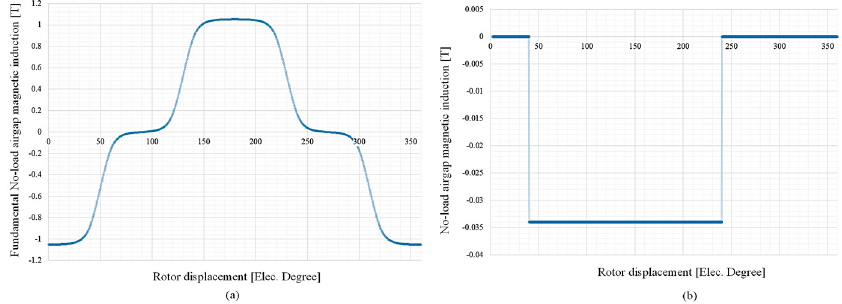
Figure 4. Comparison of no-load air-gap magnetic field density waveforms using Equations (21) and (27), for ( a ) fundamental no-load magnetic induction ( B m 1 ), and ( b ) no-load airgap magnetic induction ( B m ).